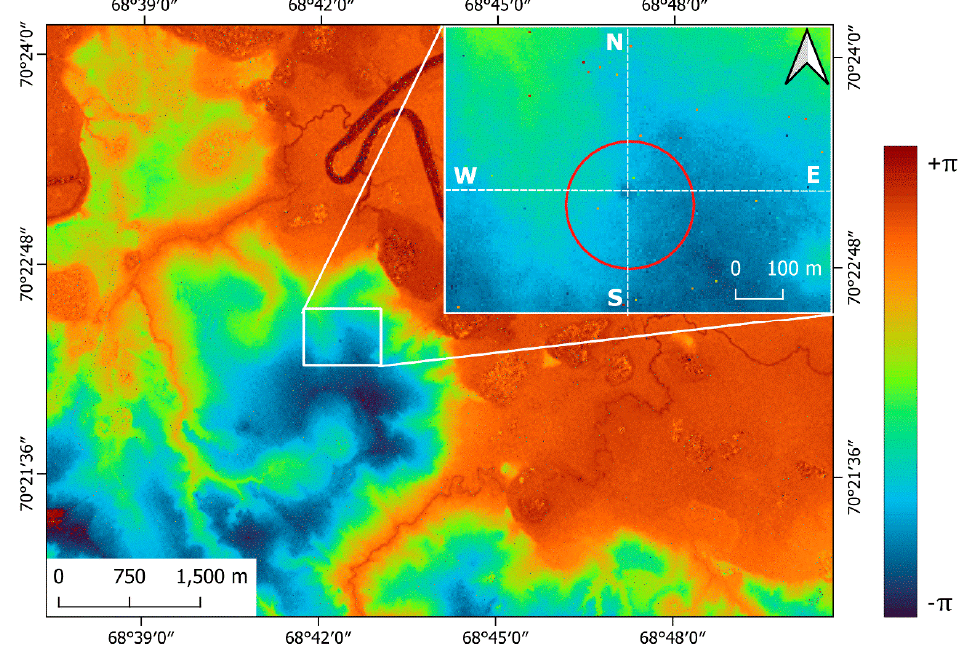
Figure 4. TerraSAR ‐ X/TanDEM ‐ X wrapped interferogram with detected PHM (30 October 2017).